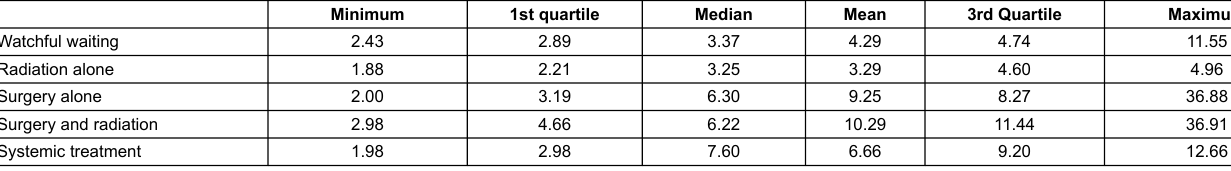
Table 3: Analysis of recurrence rates for different treatment modalities according to treatment group Treatment